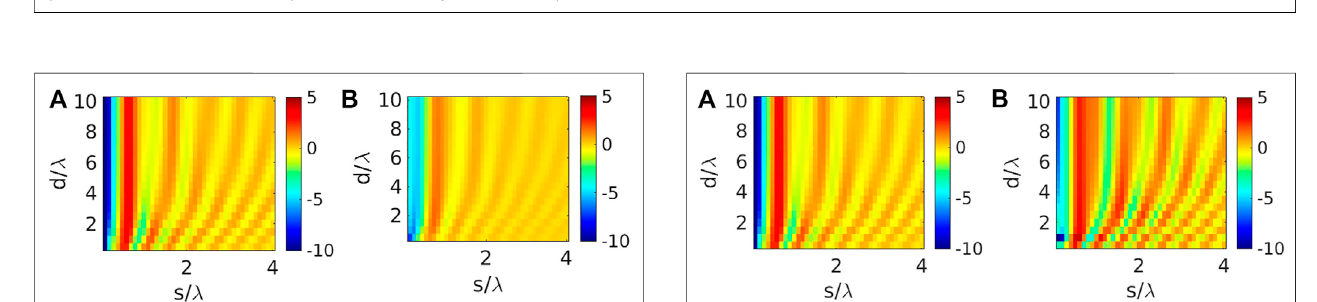
FIGURE 1 | Schematic diagram of IRS-assisted SISO communication link using two dipoles (each 0.47 λ long), realized using MATLAB Antenna Toolbox. The IRS placed near the transmitter comprises of N × N array of circular loops, each of radius r .